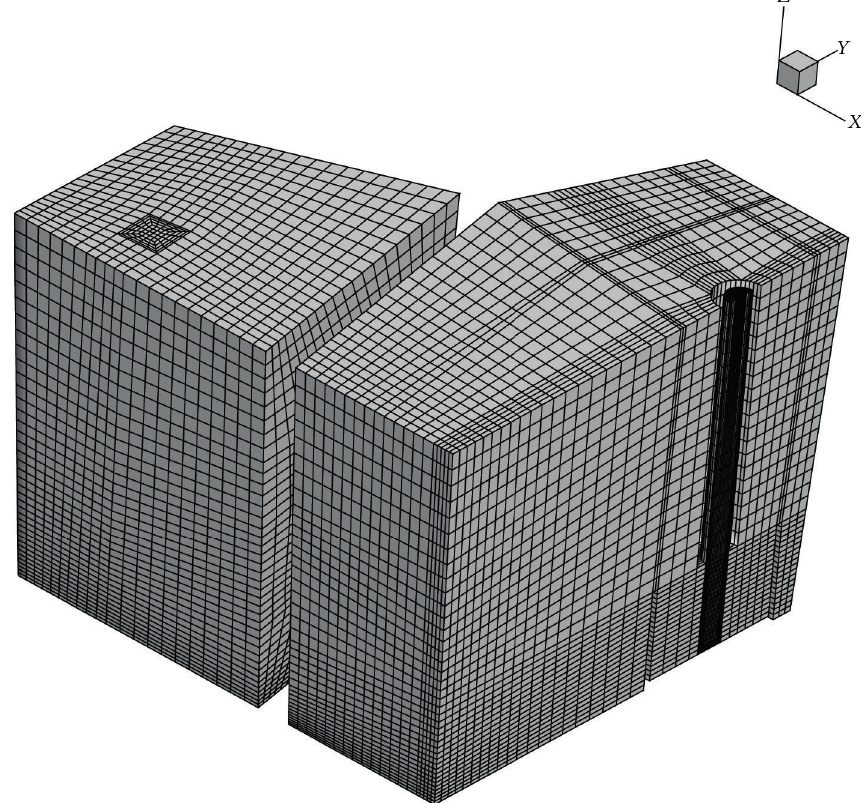
Figure 3: 3D computational mesh employed in the present model.